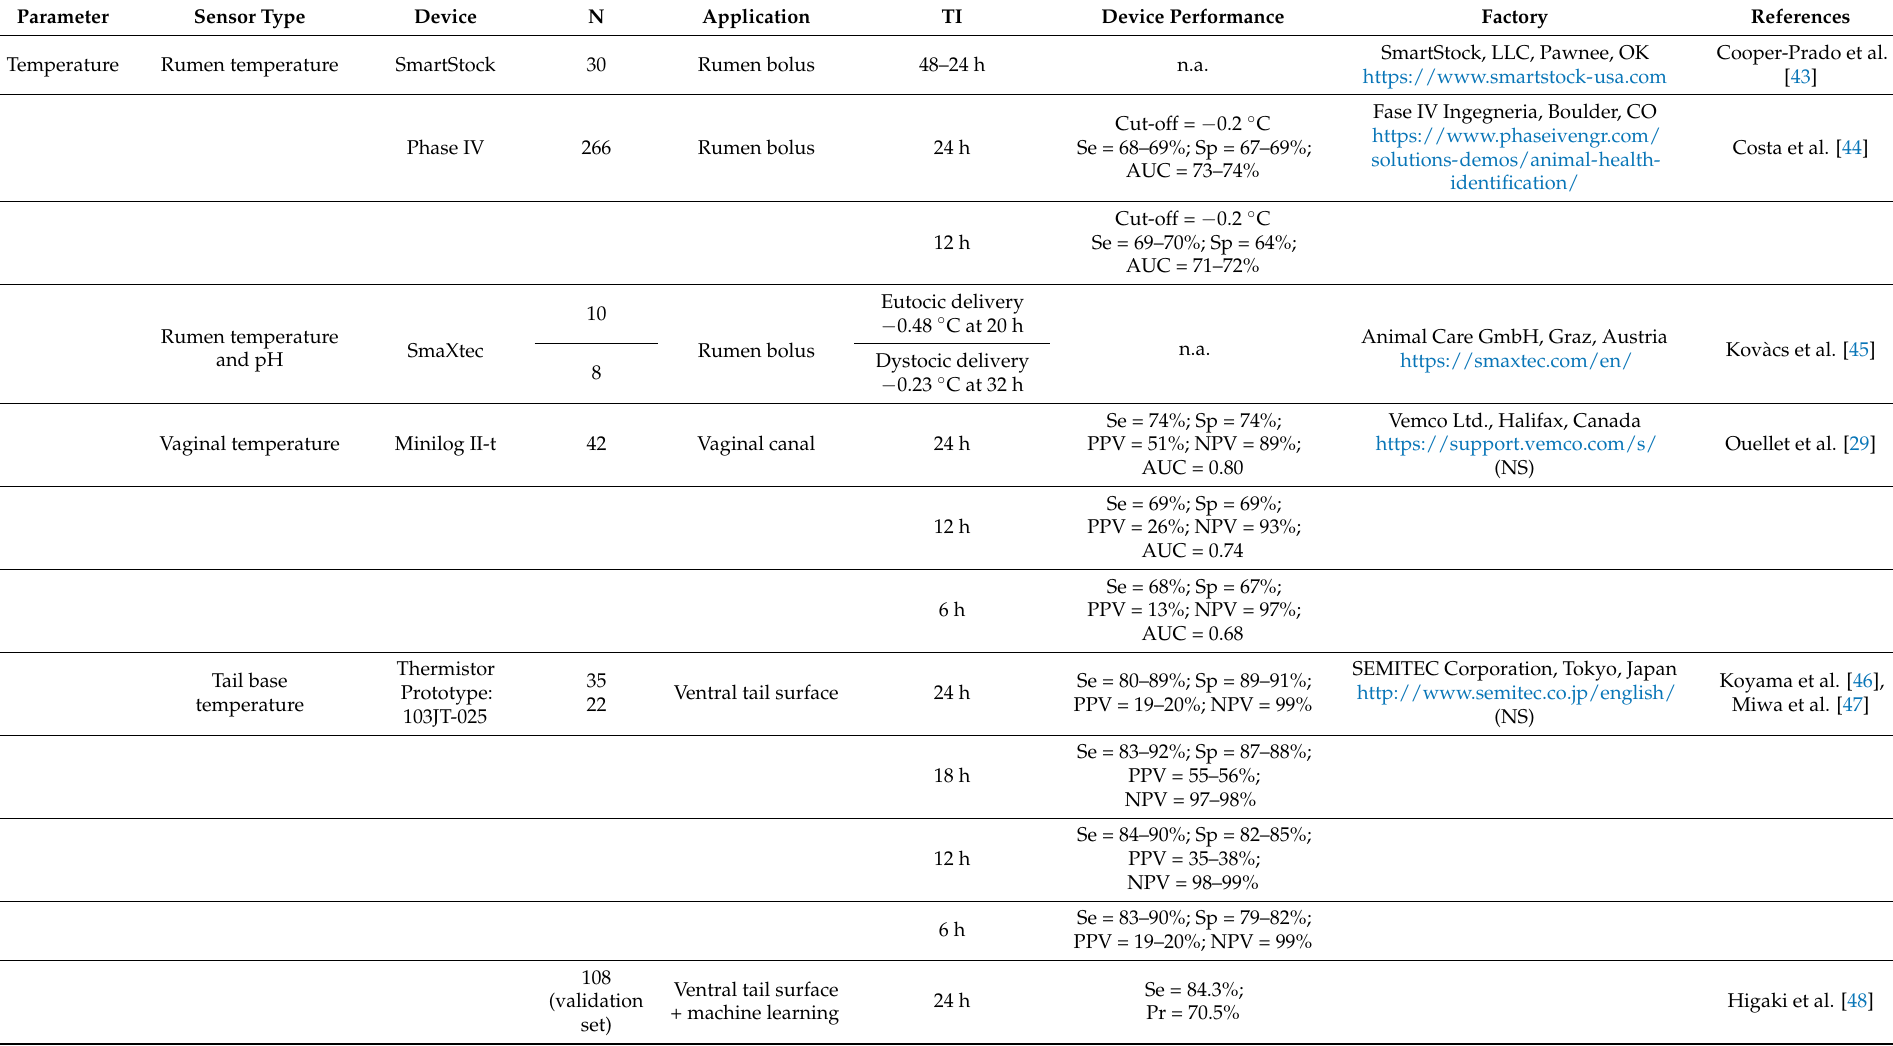
Table 3. Devices for automatic temperature monitoring for calving prediction, with performance and